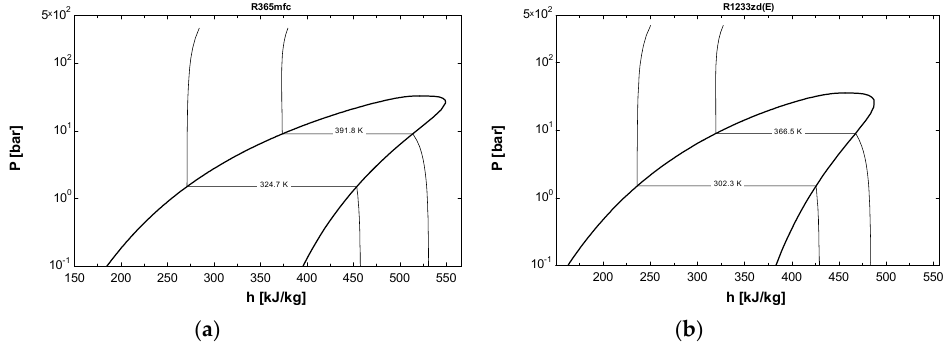
Figure 4. Comparison of a vapor compression refrigeration cycle (VCRC) on a p–h plot for ( a ) R365mfc and ( b ) R1233zd(E).